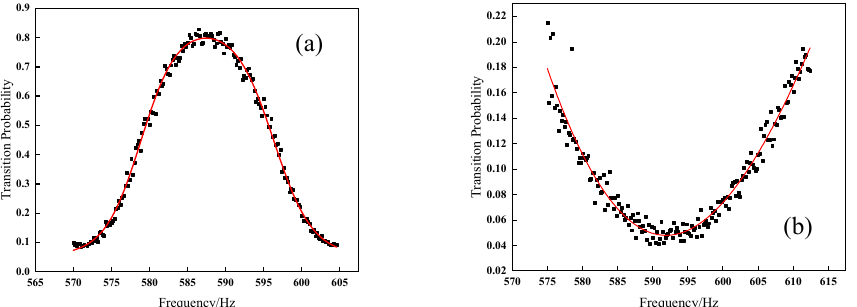
Figure 5. Curve of low-frequency transition; ( a ) 24 cm above the Ramsey cavity; ( b ) center of the Ramsey cavity.